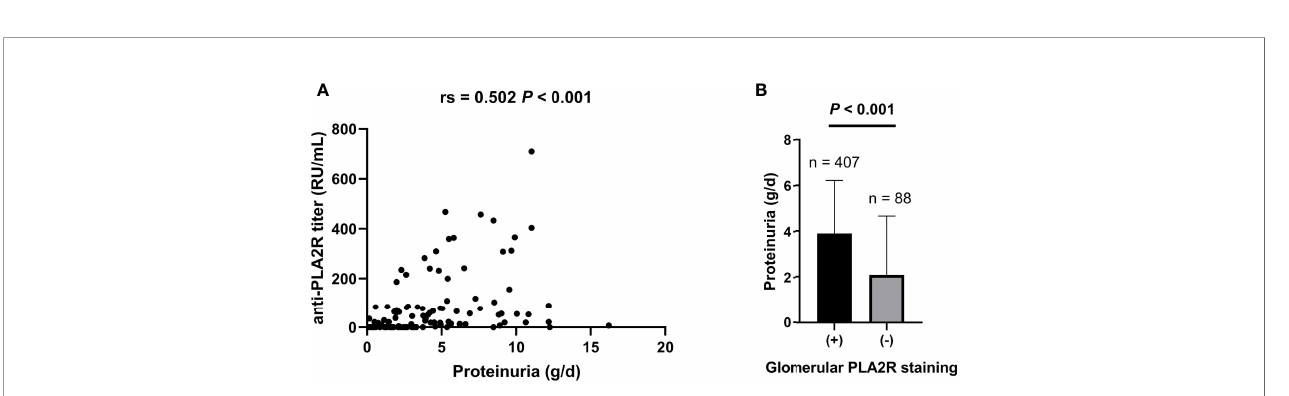
FIGURE 5 | Both baseline serum anti-PLA2R titer and glomerular PLA2R deposits are correlated with proteinuria. (A) Spearman ’ s analysis was applied for correlations between baseline serum anti-PLA2R titer and proteinuria (N = 124). (B) Mann – Whitney U test was applied to analyze the correlations between tissue PLA2R deposit and proteinuria (N = 495). Rs: Spearman ’ s rank correlation coef fi cient.